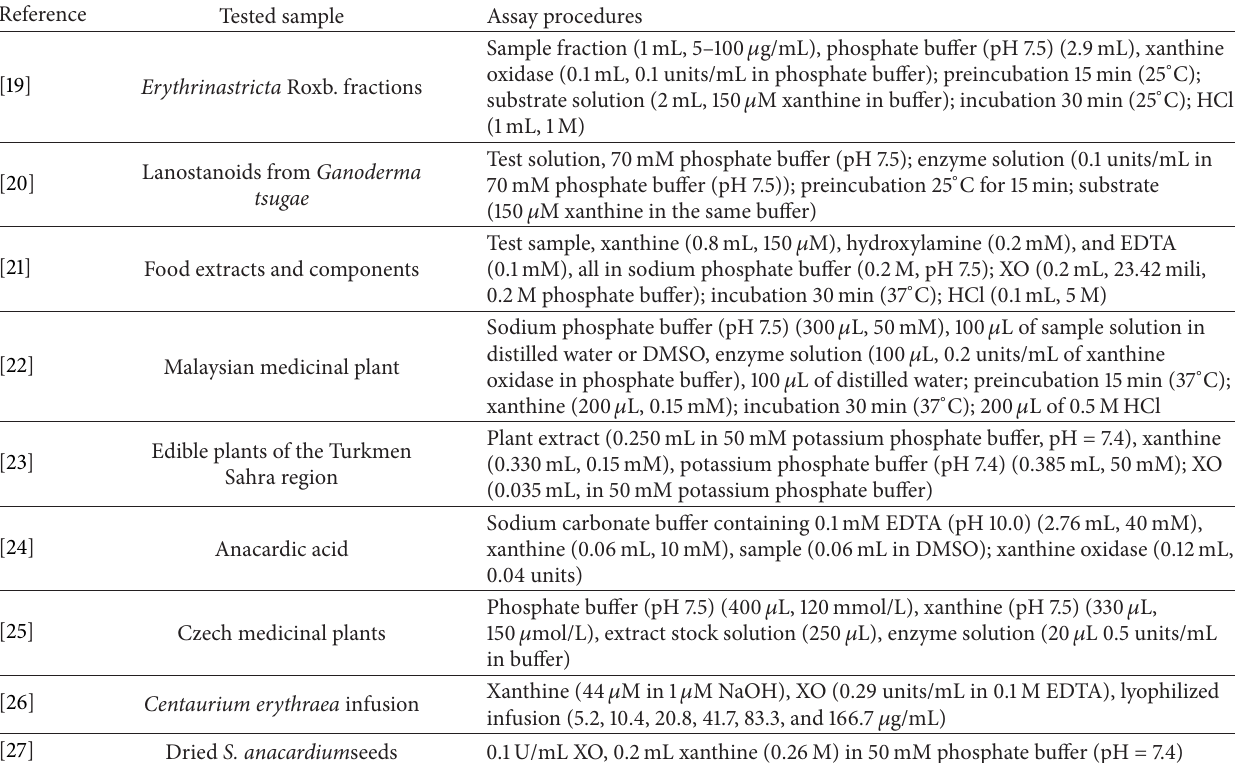
Table 1: Assay procedure of effect of plant extract on xanthine oxidase